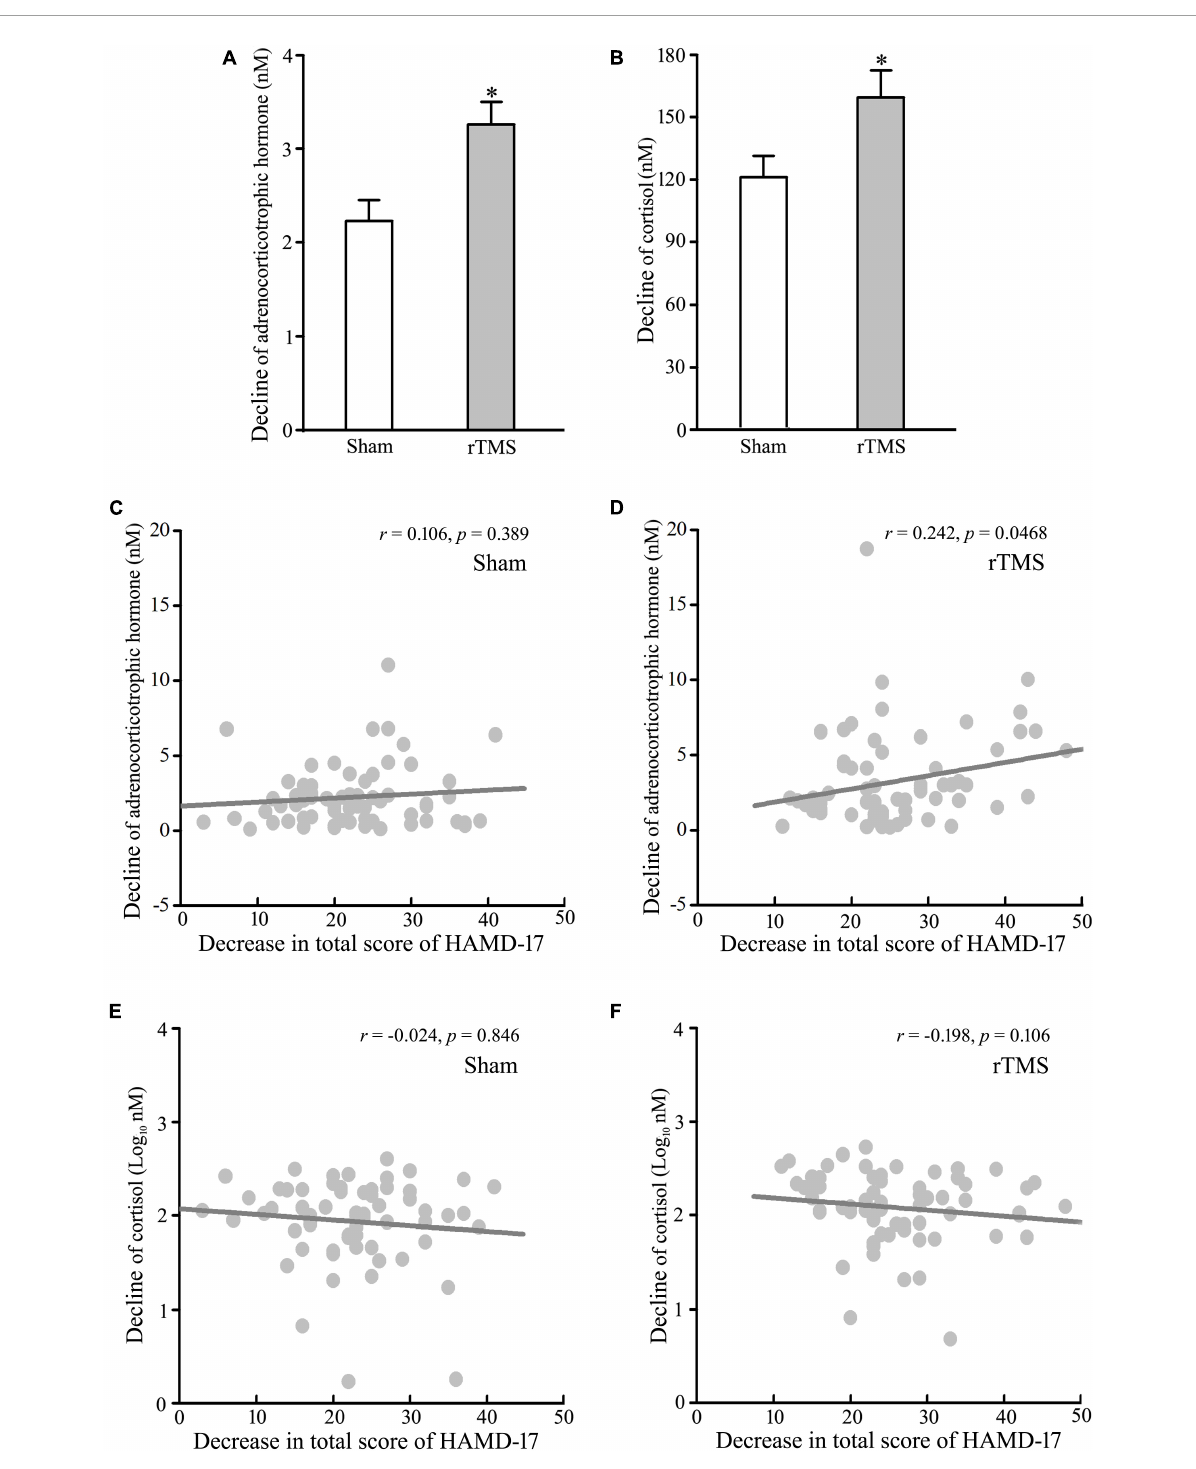
FIGURE3 Effect of repetitive transcranial magnetic stimulation (rTMS) on the hypothalamic–pituitary–adrenal (HPA) axis. Plasma adrenocorticotropic hormone (ACTH) and serum cortisol (COR) were detected at baseline and 4-week after rTMS or sham treatment. (A,B) Change in the concentration of ACTH (A) and COR (B) from baseline to post-intervention at 4 weeks. (C,D) Correlation analysis of change in ACTH to decline in a total score of 17 items Hamilton depression rating scale (HAMD-17) in the sham group (C) and rTMS group (D) . (E–F) Correlation of change in COR to decline in a total score of HAMD-17 in the sham group (E) and rTMS group (F) . rTMS group significantly different from the sham group was marked by asterisks. ∗ p < 0.05, compared with the sham group (A,B) . Graphs show mean ± SEM; n =